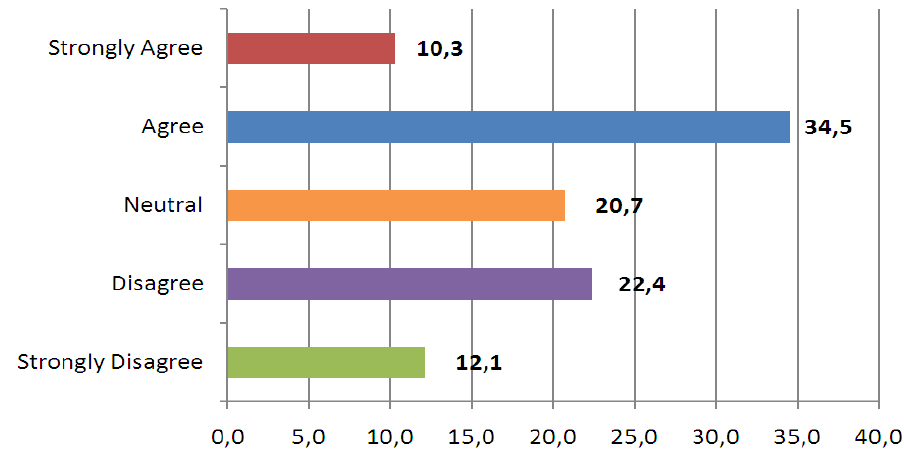
Fig. 1. Have a good understanding of Islamic banking products and services